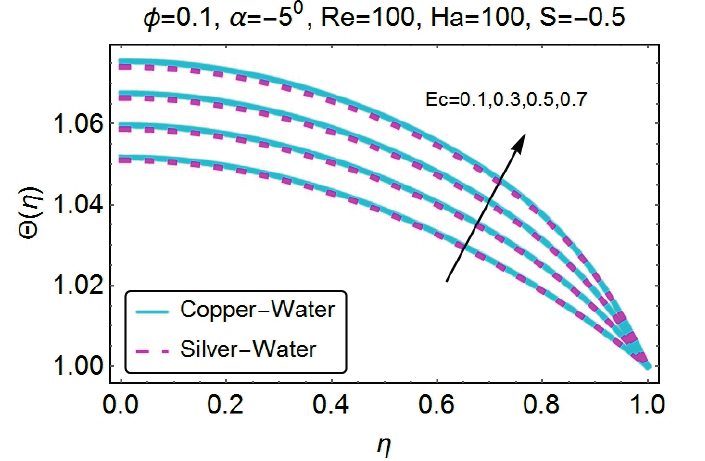
Figure 27. Change in temperature for varying Ec (convergent channel/shrinking